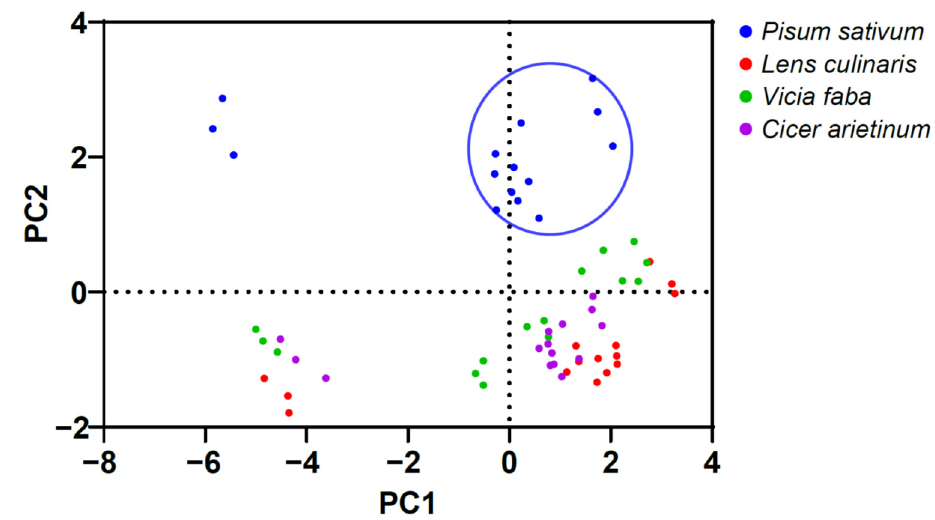
Figure 11. The principal component analysis plot (PCA) of plants in 0.5 L pots filled with commercial garden soil that were treated by watering 100 mL of 0.5 mg L − 1 NSAIDs every second day over a total of 20 days. PCA 1 and 2 explain 70.23% of the variation (55.7% and 14.5%, respectively). See Supplementary raw data in Table S1.